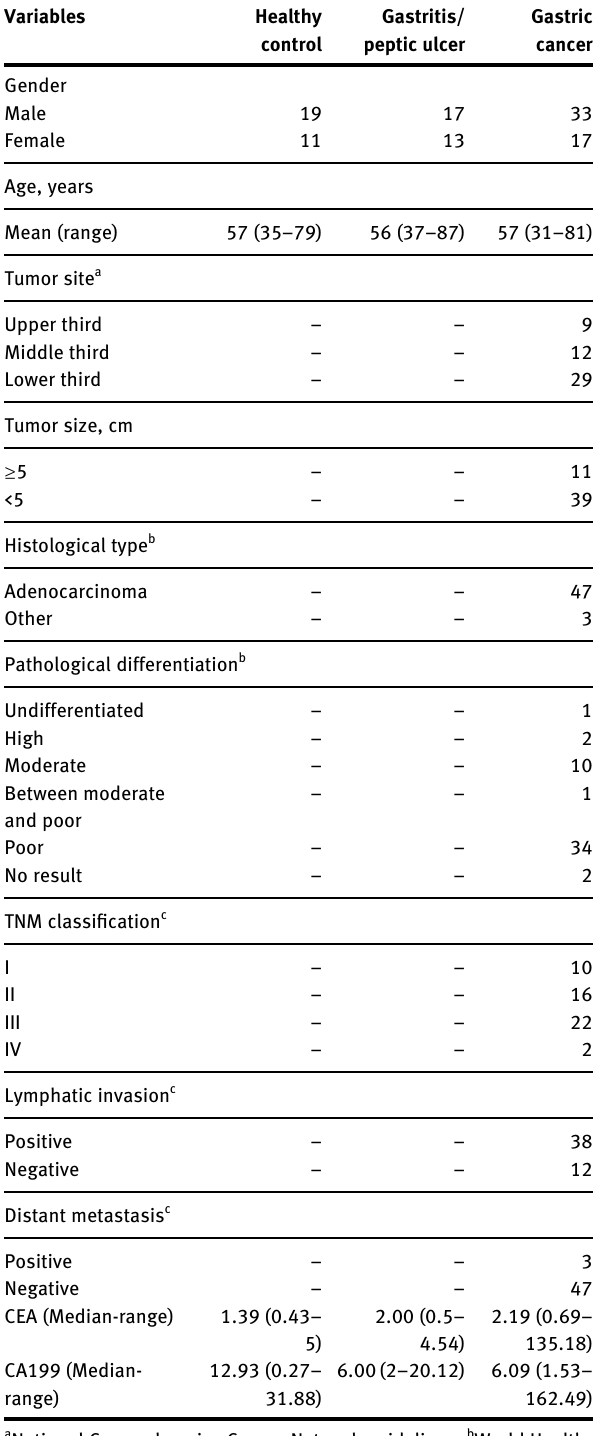
Table  : General characteristics and clinicopathological factors of gastric cancer patients and healthy control